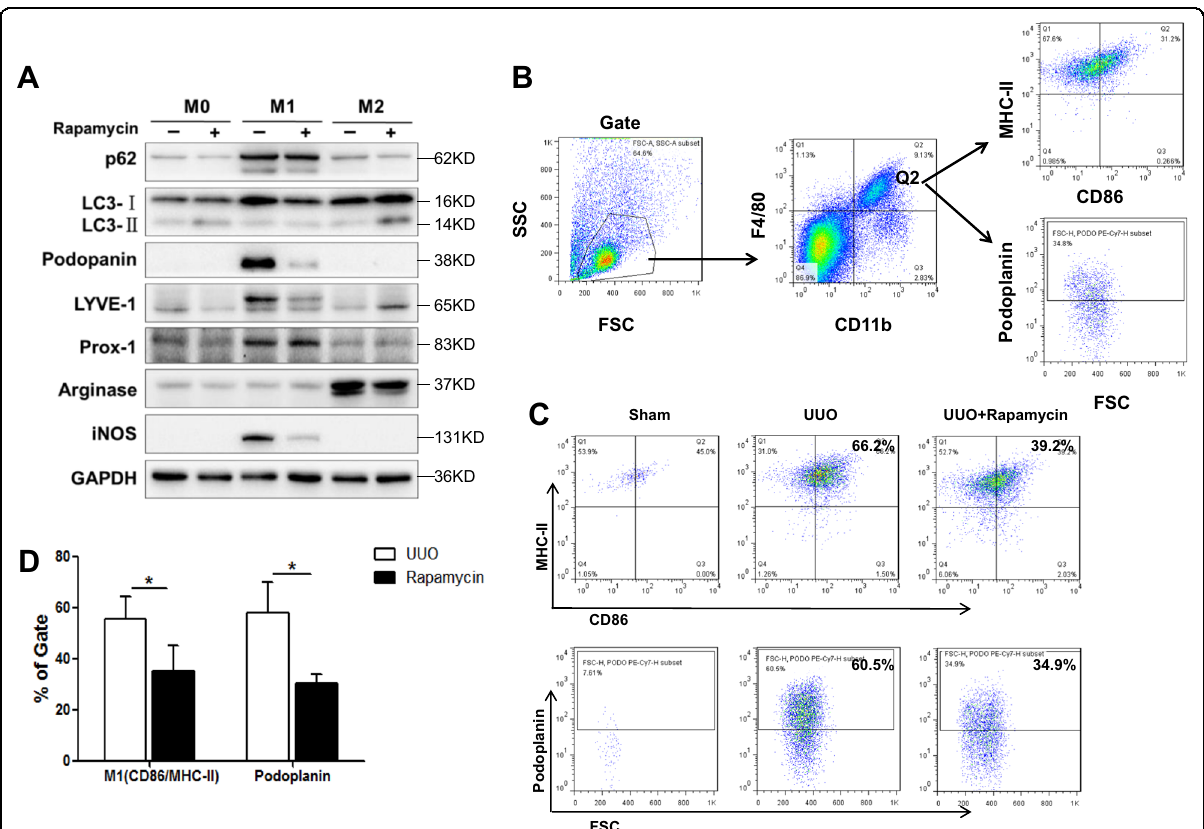
Fig. 8 Rapamycin upregulated macrophage autophagy and ultimately downregulated macrophage transdifferentiation into LECs. A Autophagy was induced in primary BMDMs by rapamycin, and the expression of macrophage polarization markers (arginase and iNOS) and lymphatic vessel markers (podoplanin, LYVE-1, and Prox-1) was measured by western blotting. B – D Rapamycin affected macrophage polarization and transdifferentiation in UUO mice. Macrophage activation and the expression of lymphatic vessel markers were measured by fl ow cytometry. Panel B shows the gating method: macrophages were double-positive for F4/80 and CD11b, of which CD86 + MHC-II + cells were M1 and podoplanin + cells were considered LECs. The upper panel in C shows that rapamycin decreased M1 polarization in UUO mice, and the lower panel in C shows that rapamycin also decreased lymphatic vessel marker expression in in fi ltrated macrophages in UUO mice. D is the statistical graph of the data in ( C ). * p < 0.05. N =